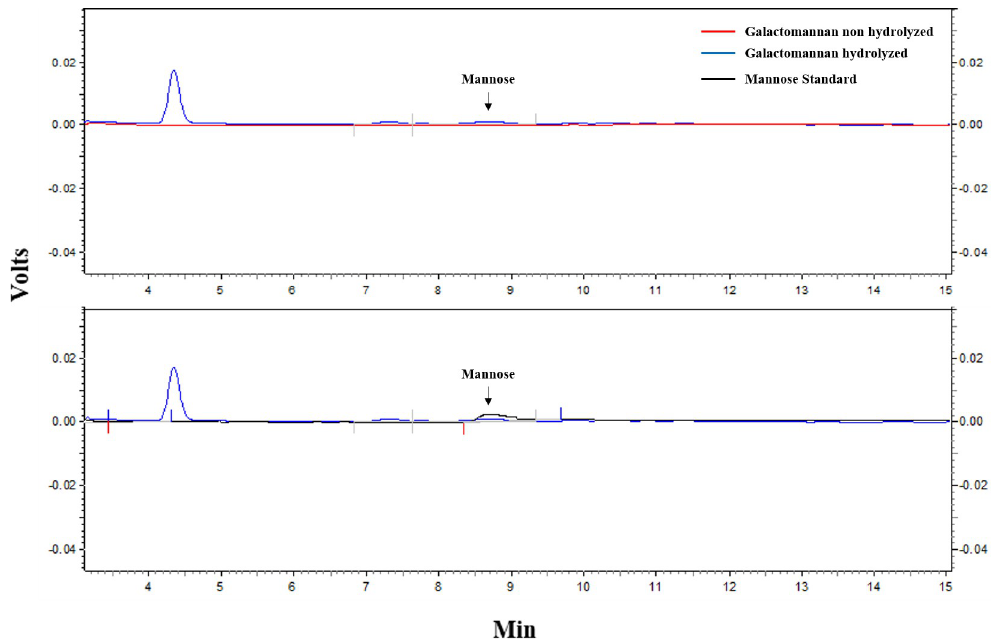
Fig 4. Chromatograms of the sugar profile of the culture medium with galactomannan grown with CB10 were detected by HPLC-RID, demonstrating the degradation of the polysaccharide generating mannose (Blue), as was evinced by the comparison of the overlapping of the pure solution pattern that demonstrates the location of the peak mannose (black), which is absent in the control sample (culture medium without cultivation, red).